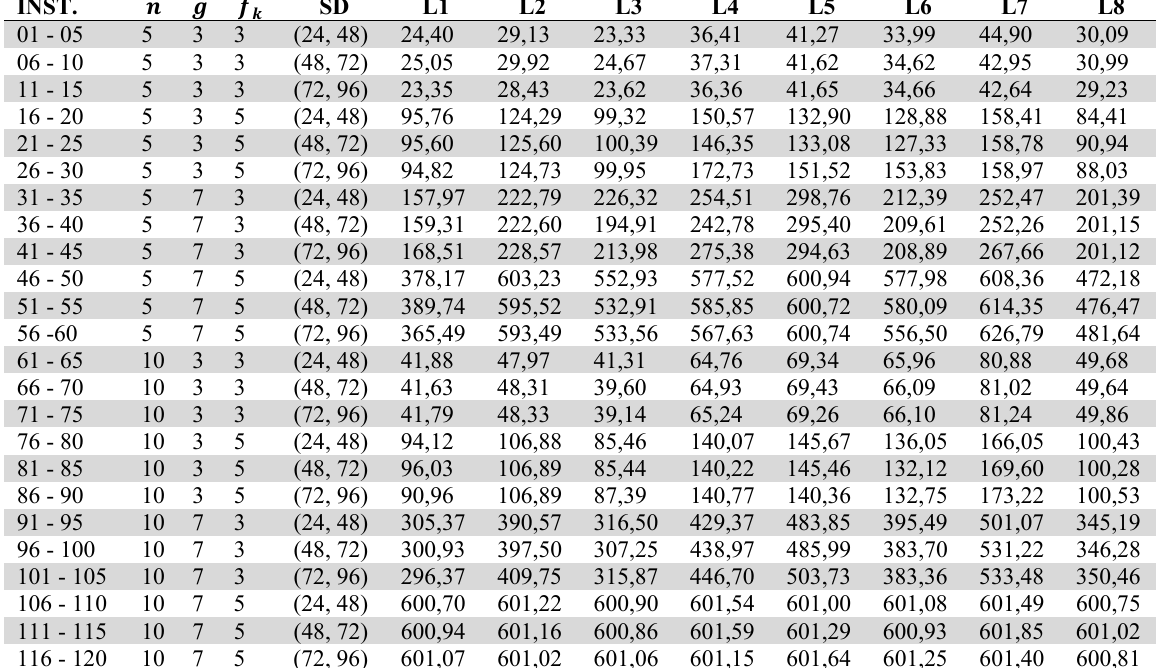
Taguchi Design - Summarize of Times